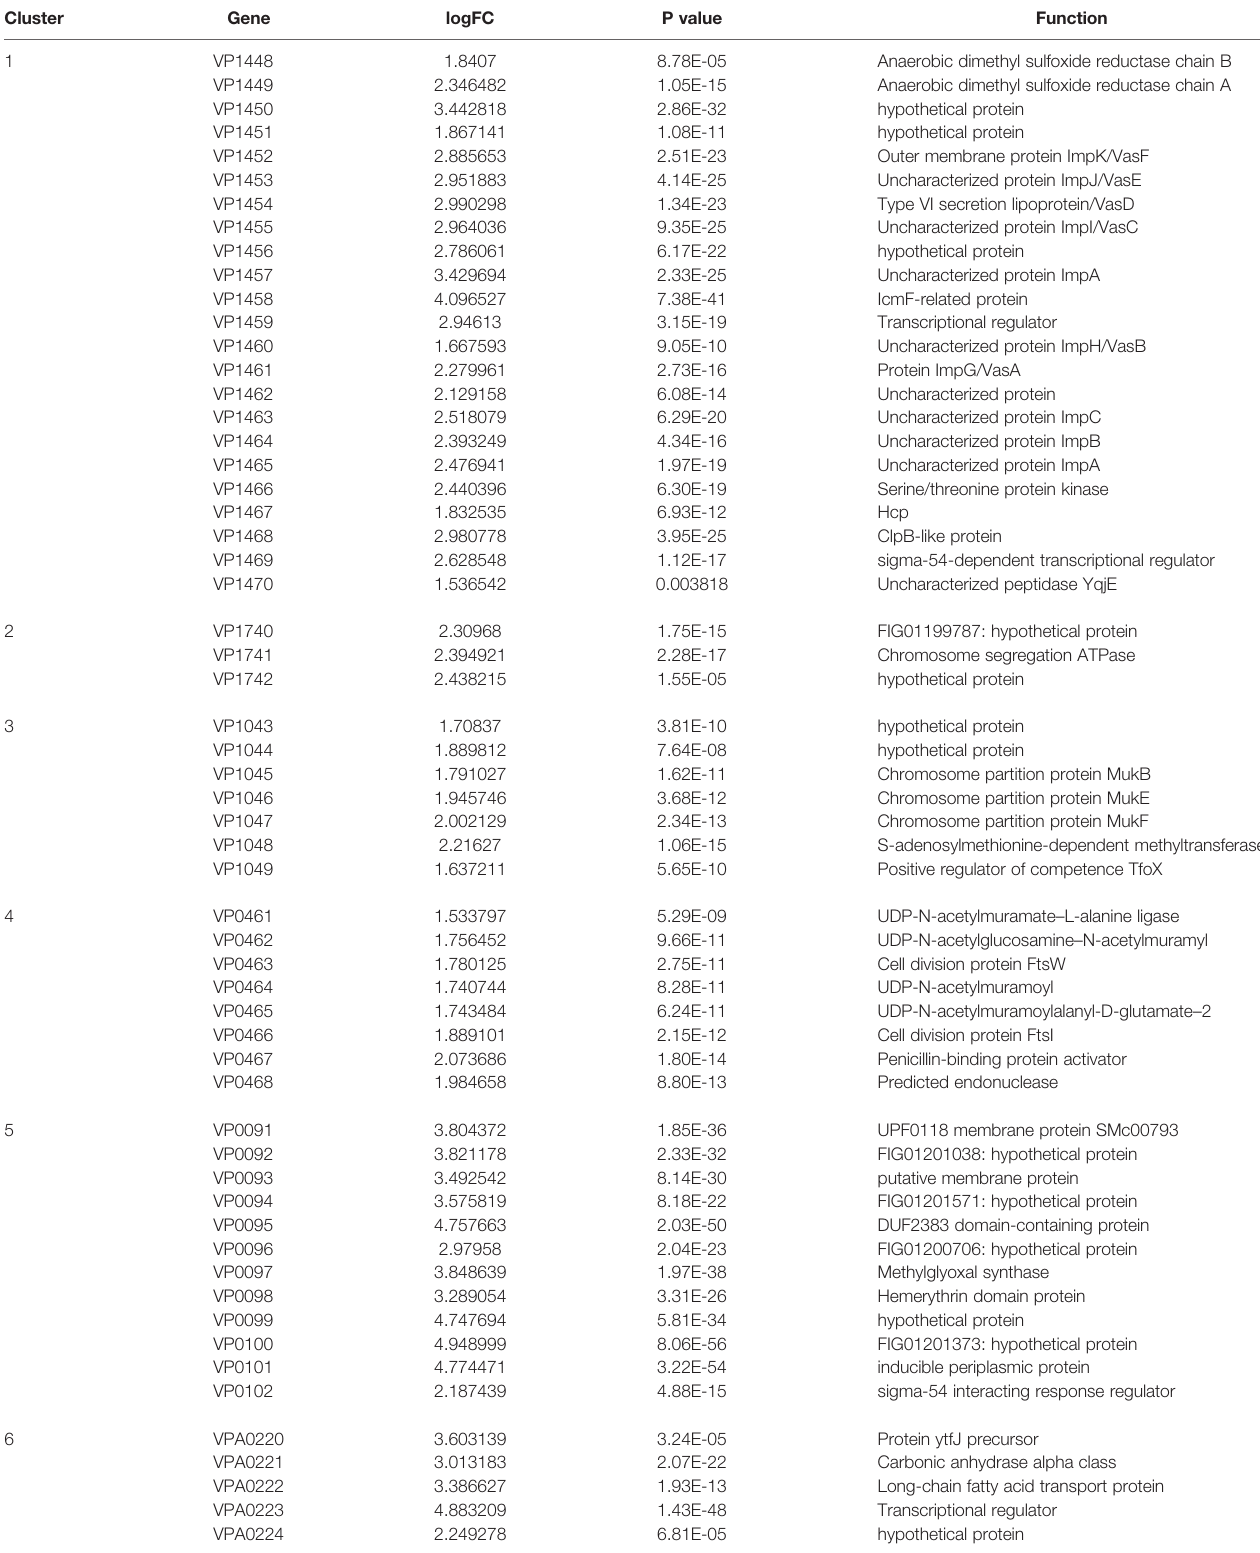
TABLE 3 | Genes up-regulated (> 1.5-fold change) in the mutant strain. Cluster